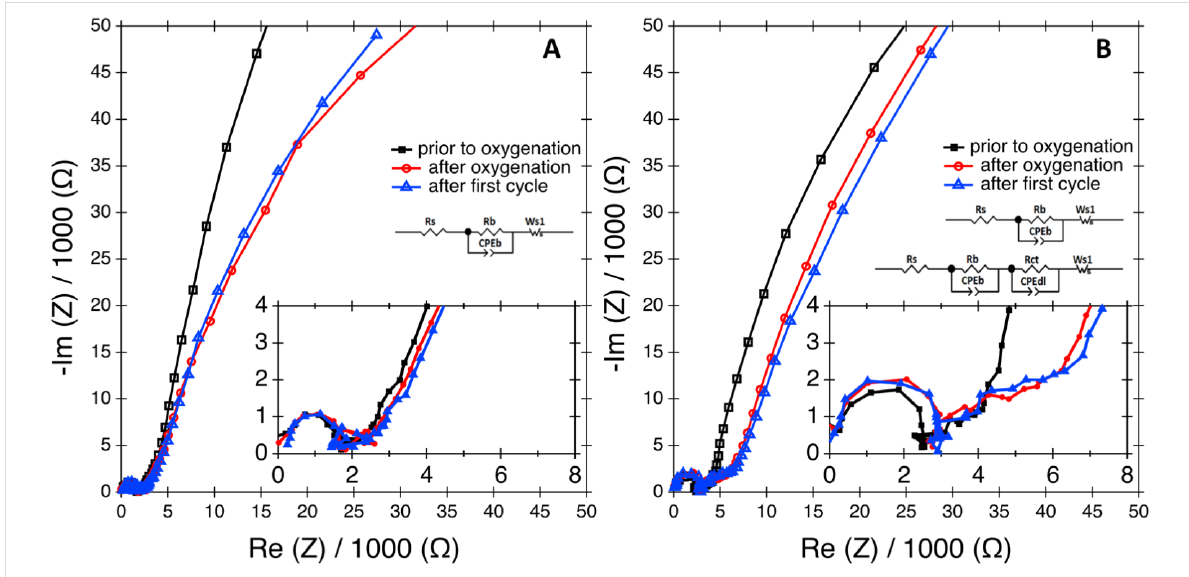
Figure 2: Electrochemical impedance spectroscopy (EIS) curves collected before (square points) solvent oxygenation, after solvent oxygenation for two hours (circle points) and after the first discharge–recharge cycle (triangle points). The EIS data were collected for cells with 1 M LiNO 3 in TEGDME with <20 ppm (A) and 2500 ppm (B) of water in the electrolyte. Fitting parameters used in the equilvent circuit mode(s) shown in the inset are presented in Table S1 of Supporting Information File 1. Prior to oxygenation, and for all EIS measurements with <20 ppm water, an equivalent circuit with a constant phase element (CPEb) was used and the rest of the EIS spectra were fit with equivalent circuits that included both CPEb and